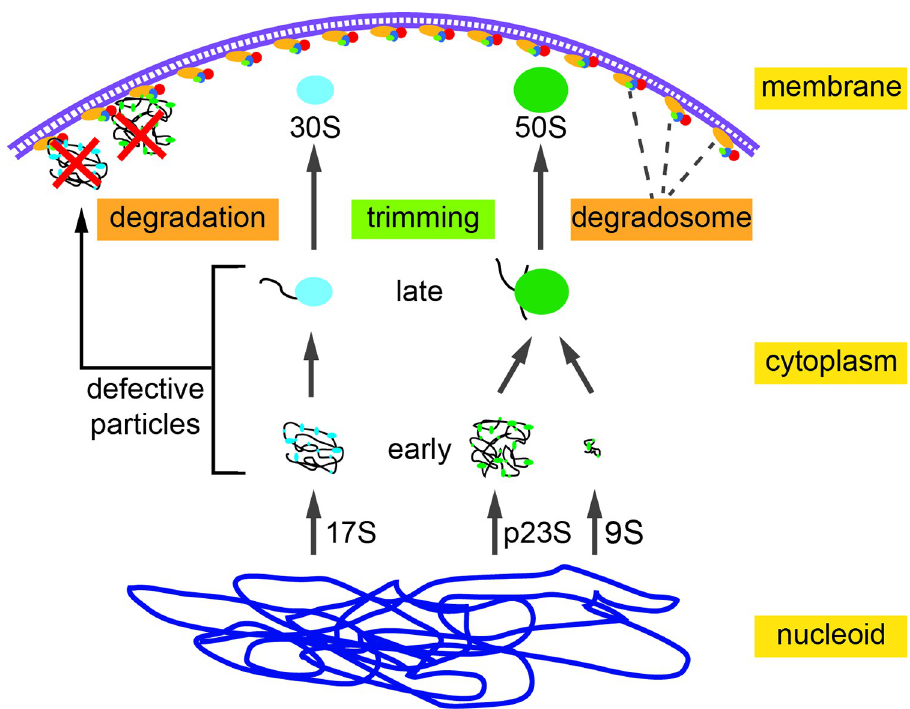
Fig 7. Quality control of ribosome assembly by the membrane-attached RNA degradosome. Cartoon depicting the synthesis of rRNA in the nucleoid, the release of early intermediates in ribosome assembly from nucleoid, maturation of late intermediates in the cytoplasm, and trimming of 17S and 9S rRNA by the membrane-attached RNA degradosome. Defective ribosomal particles are degraded by the membrane attached RNA degradosome. In this model, compartmentalization of ribosome assembly to the interior of the cell and the RNA degradosome on the inner cytoplasmic membrane shields intermediates in ribosome assembly from degradation, thus avoiding wasteful turnover of rRNA. Defective particles can be either newly synthesized intermediates that have failed to properly fold or mature ribosomal subunits that are inactive (see Discussion).